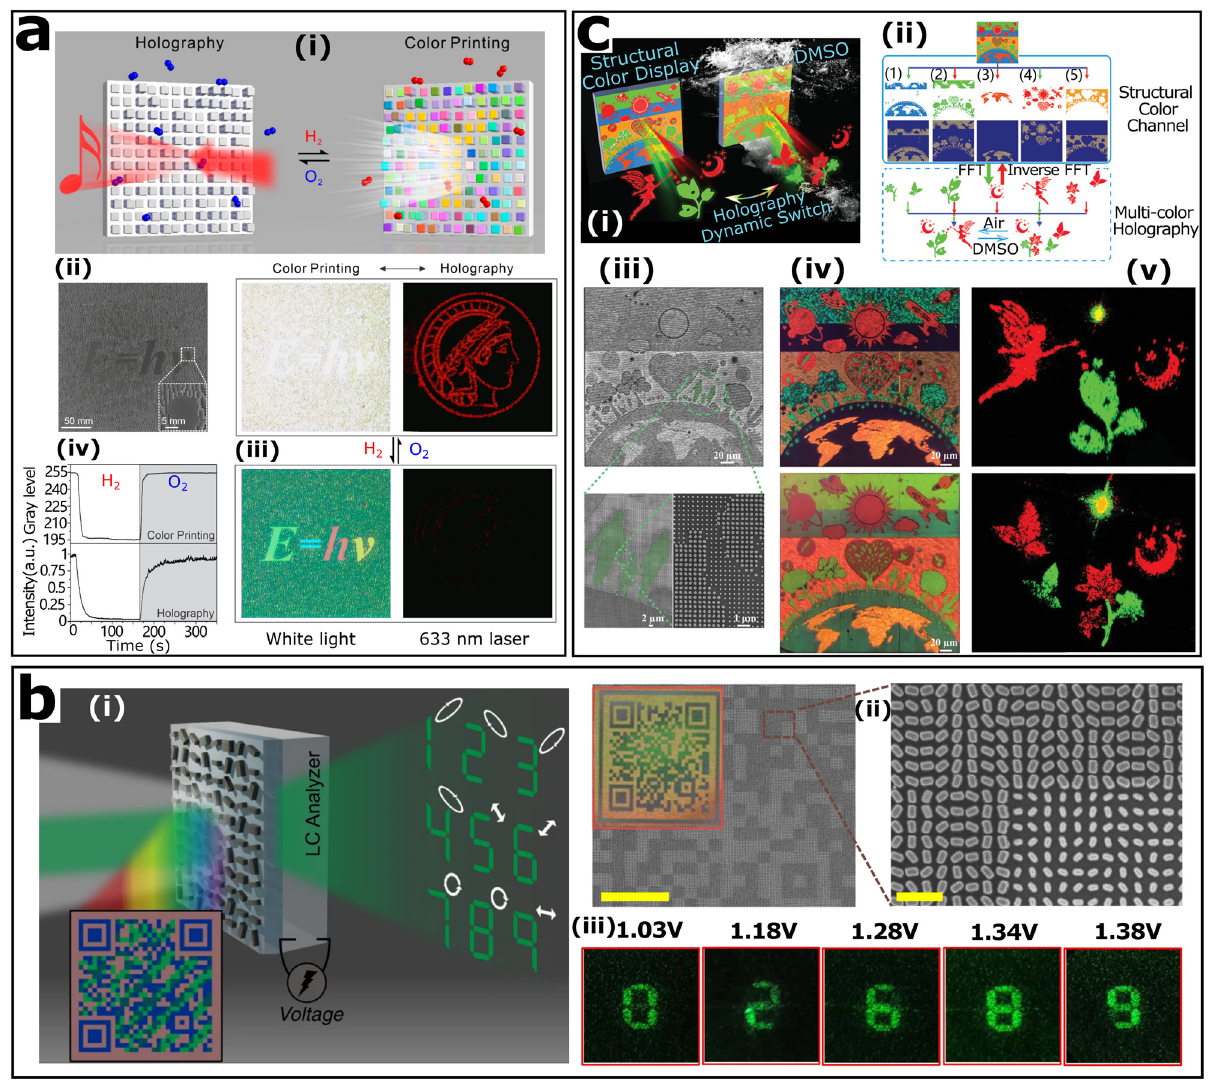
Figure 8: Tunable metasurfaces with a combination of color nanoprinting and